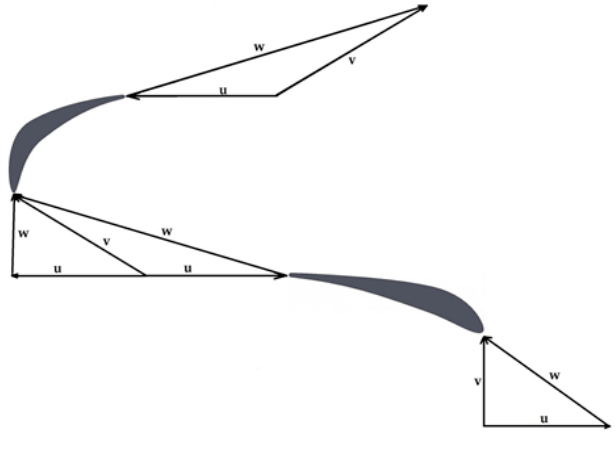
Figure 12. Velocity triangles for the first two rows.